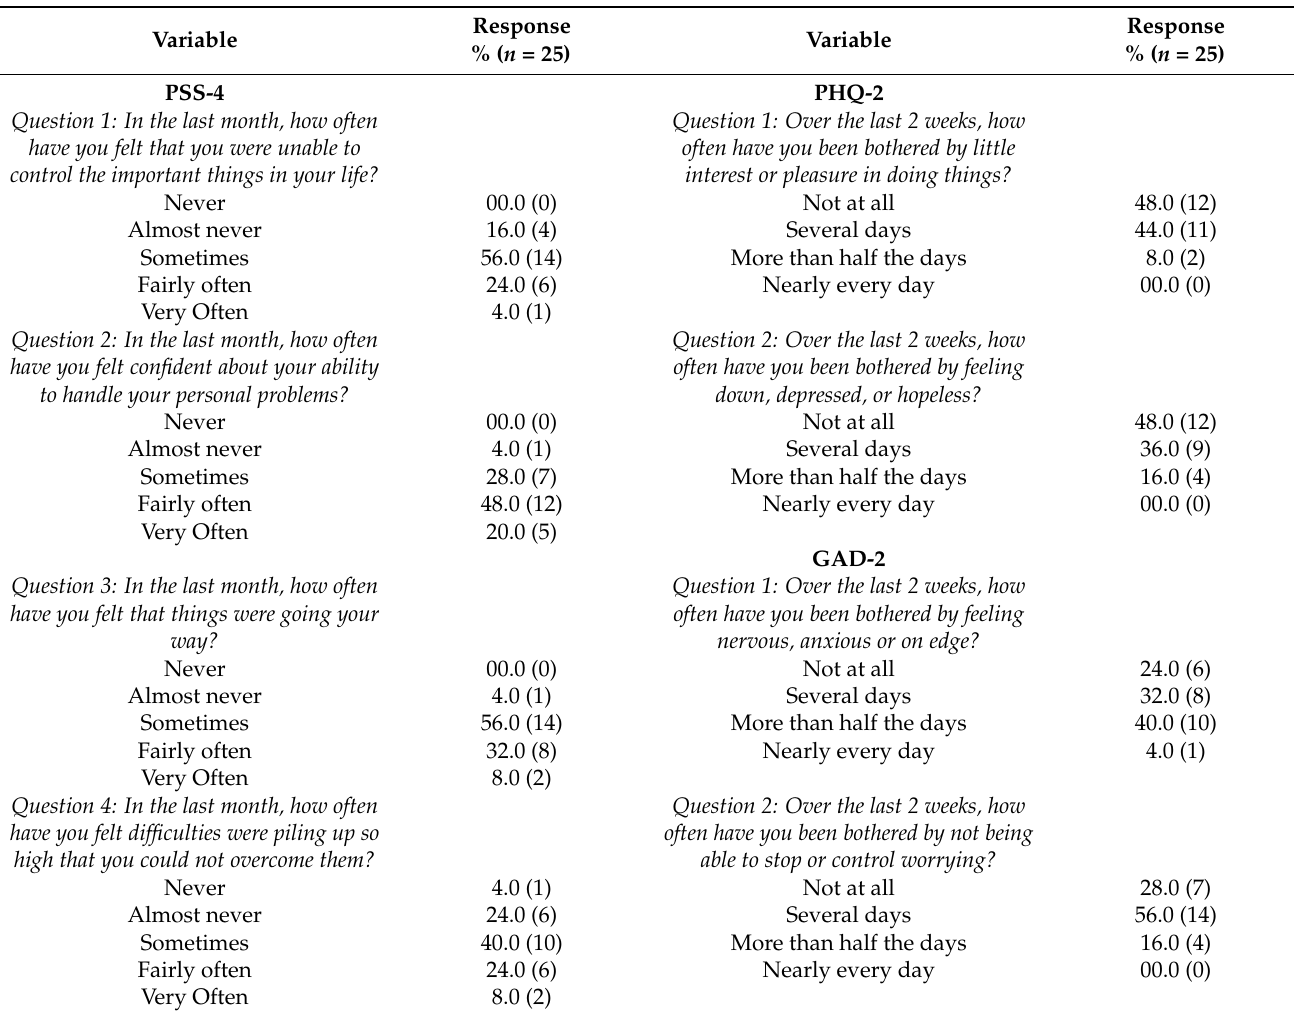
Table A1. PSS-4, PHQ-2 and GAD-2 detailed